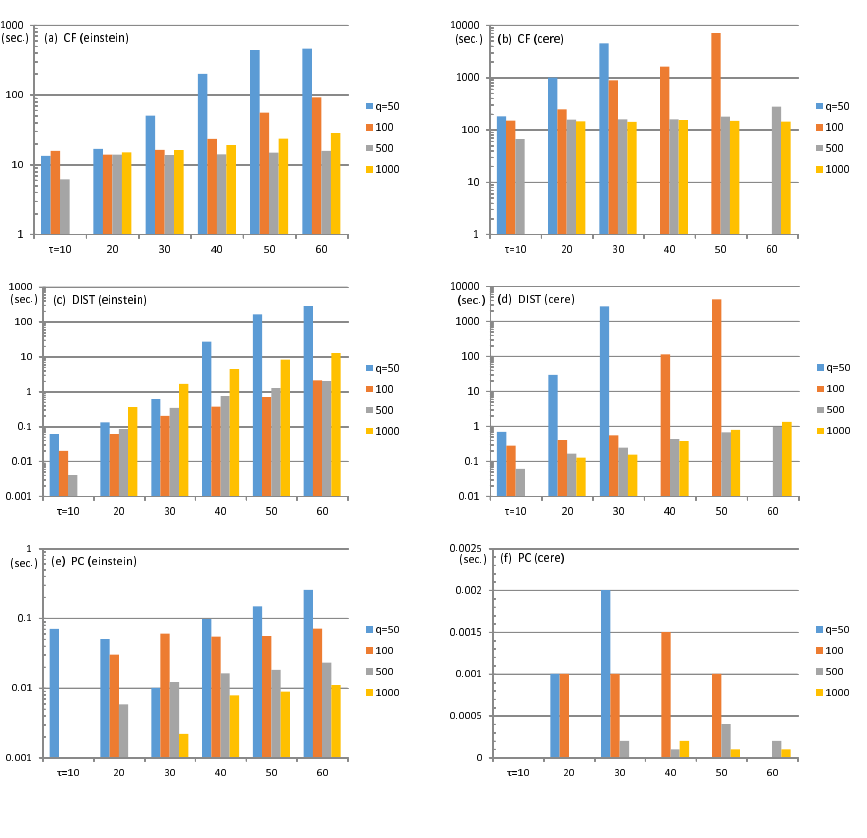
Figure 6. Details of search time for different | Q | and τ : time for candidate findings, CF, time for L 1 -distance computations, DIST, and time for position computations, PC. ( a ) and ( b ) correspond to CF, ( c ) and ( d ) correspond to DIST, and ( e ) and ( f ) correspond to PC of einstein and cere,